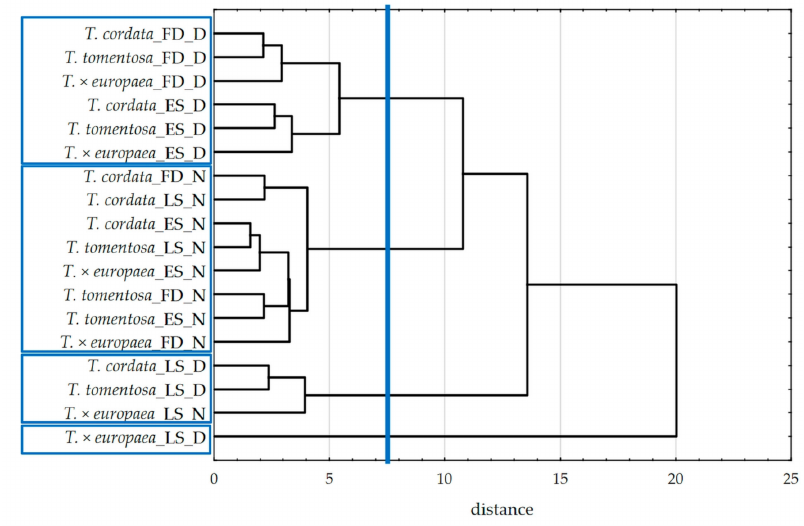
Figure 5. The results of the cluster analysis presented as a dendrogram. All treatments were classified based on all of the presented parameters (pigment contents and ratio as well as the ChlF parameters) using the Euclidean distance and Ward’s method; the blue line indicates the cut-off point; and blue Forests 2021 , 12 , x FOR PEER REVIEW 11 of 17 rectangles show separate clusters.